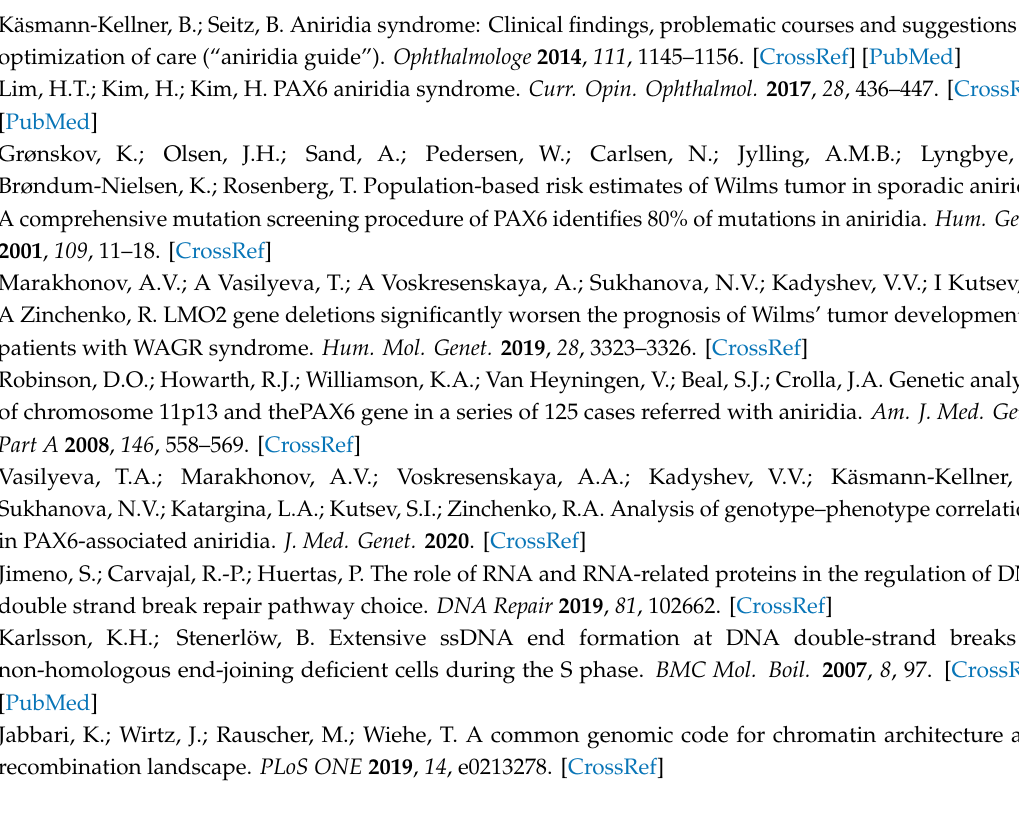
Table S1: Summary of analyzed